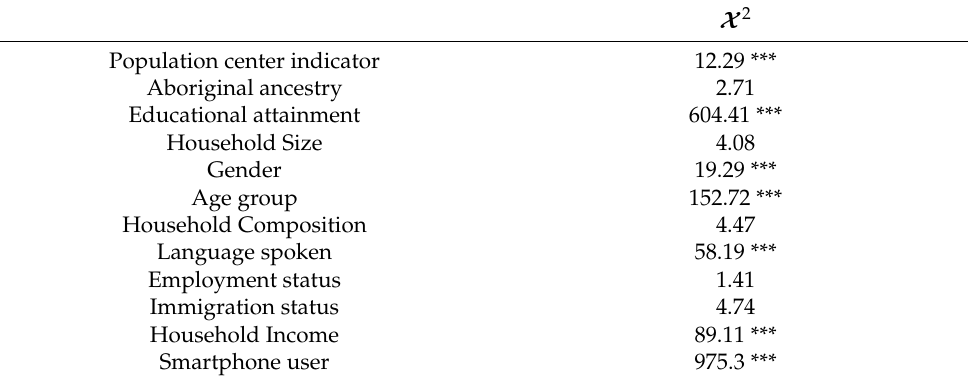
Figure A1. Disadvantaged Groups. Source: Canadian Internet Use Survey, Statistics Canada, 2018. Table A1. Parameter Test.